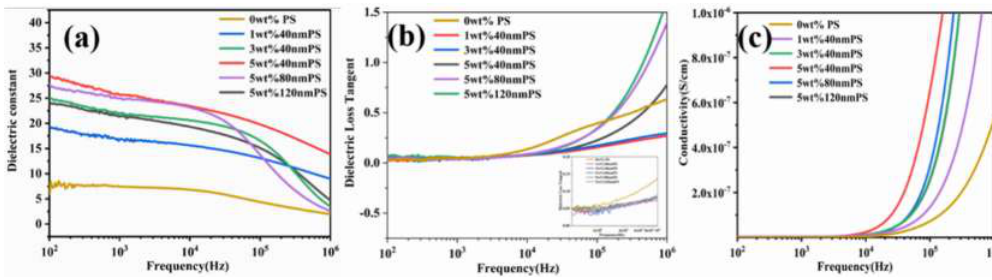
Figure 9. Dielectric properties of blend films with different PS mass fraction: ( a ) Dielectric constant, ( b ) dielectric loss, and ( c ) electric conductivity.